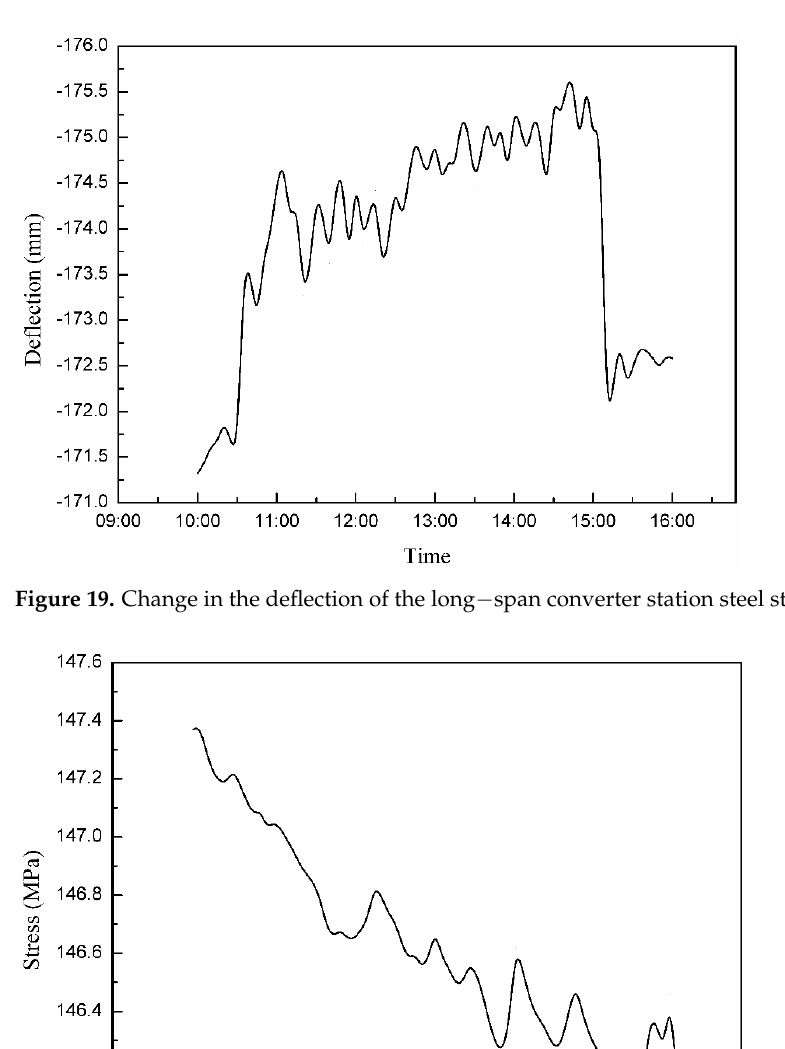
Figure 20. Change in the stress of the long − span converter station steel structure. With the monitoring system, the deflection and stress changes of the long-span con- verter station steel structure can be monitored in real-time during the lifting process, such that on-site lifting and monitoring can be synchronized. When the deflection and stress of the long-span converter station steel structure are close to the critical value of risk, the construction should be stopped in a timely manner for safety investigation, resulting in the real-time warning and the timely treatment of potential safety hazards. During the